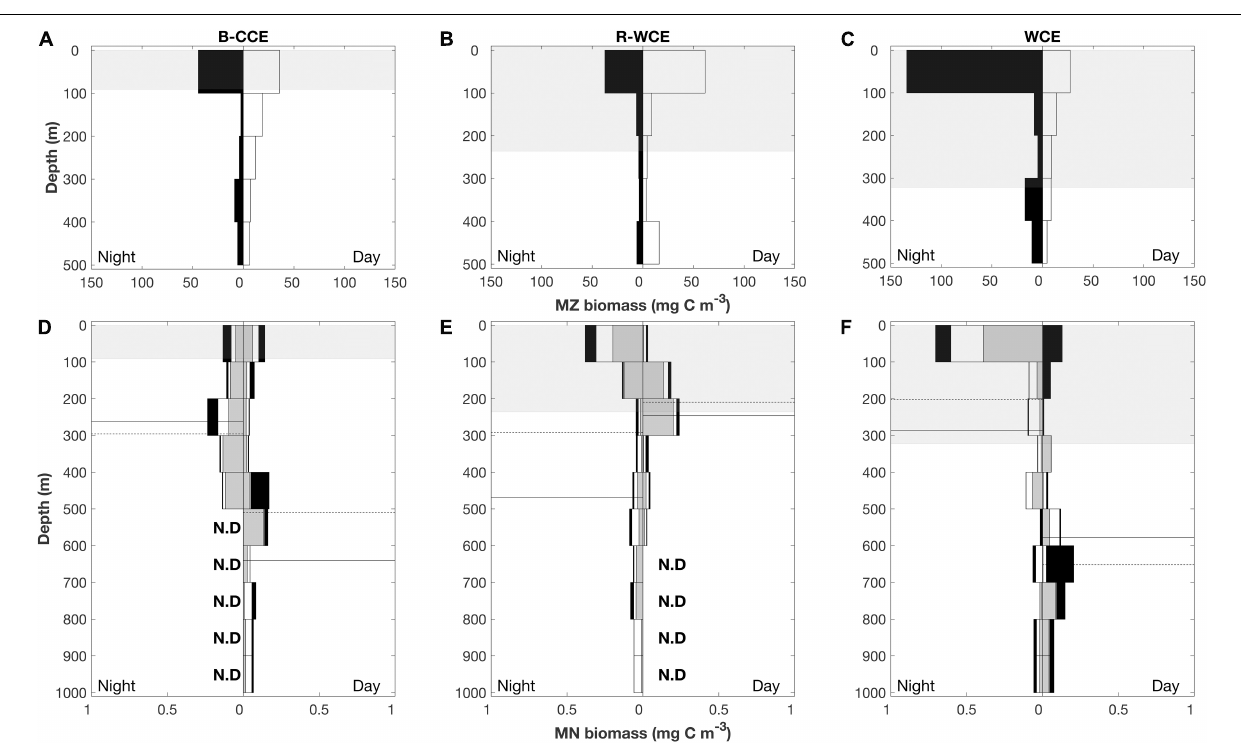
FIGURE 5 | Depth profile of mesozooplankton (MZ; A–C ) and micronekton (MN; D–F ) in the B-CCE, R-WCE, and WCE. Micronekton biomass is split into myctophids (gray), decapods (white), and all other micronekton (black). Nighttime profiles are left-hand panes, and daytime profiles are right-hand panes. Dashed lines represent weighted mean depths for myctophids solid lines represent weighted mean depths for decapods. Shaded gray areas represent mean ( ± SD) mixed layer depth. N.D indicates no